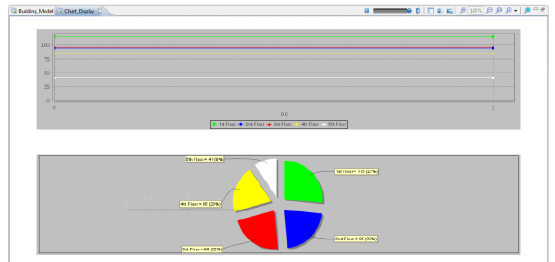
Figure 7. A screen capture image of the PEOPLE agents population chart at time = 1 second